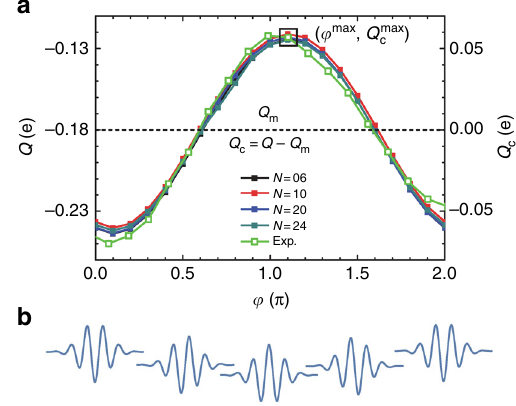
Fig. 3 Phase and size dependence of the laser-induced currents. a Dependence of the net transferred charge on the laser carrier envelope phase φ and junction size N ( E || a , μ F = 7.5 eV, E 0 = 1.7 V Å − 1 ). b Scheme of the laser fi eld for different φ . In agreement with experiment 4 (green, magnitude scaled), Q ( φ ) is a sinusoidal function of φ with a period of 2 π . The total response Q = Q m + Q c consist of a phase-controllable component Q spatial asymmetry in α -quartz. The black square signals the